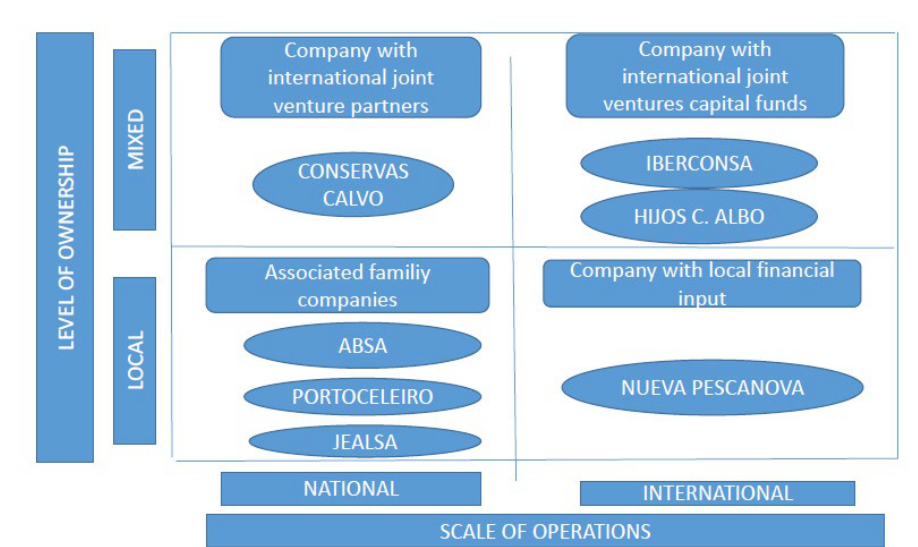
Chart 1. Diagram of Galician fishing companies according to their levels of ownership and scale of